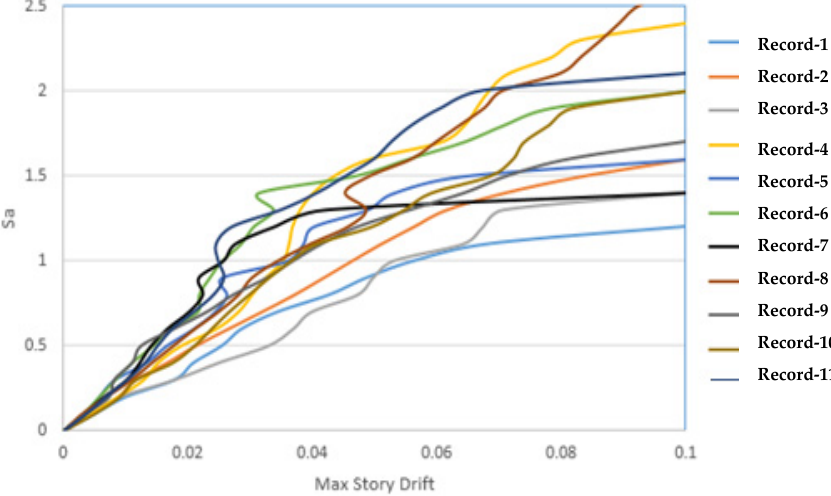
Figure 18. IDA curves obtained for a 10-story building with semi-rigid connections.